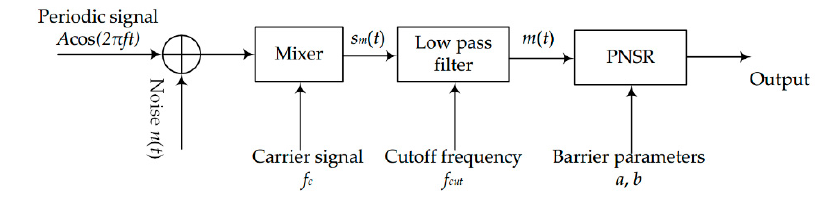
Figure 8. The flow of MNSR.